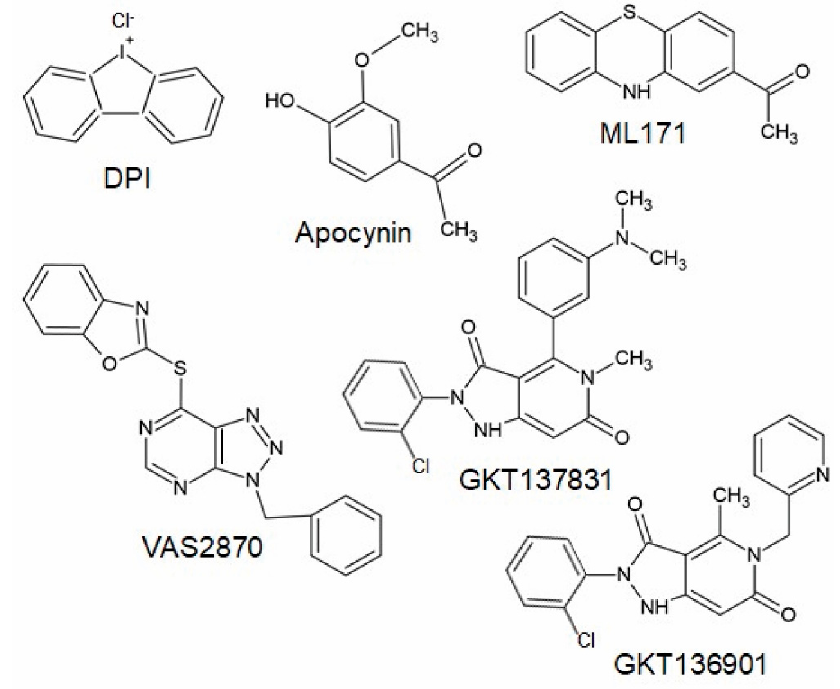
Figure 4. Chemical structures of potential Nox inhibiting compounds (abstracted from [125,133]).